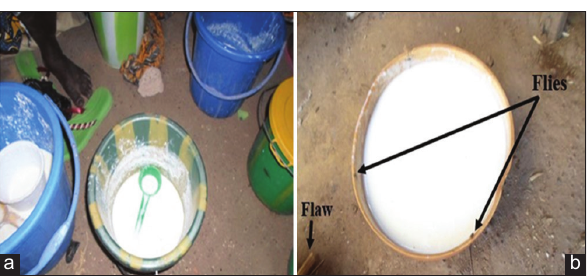
a Figure-5: Milk sale in Dori (a) and Gorom-Gorom (b) market.